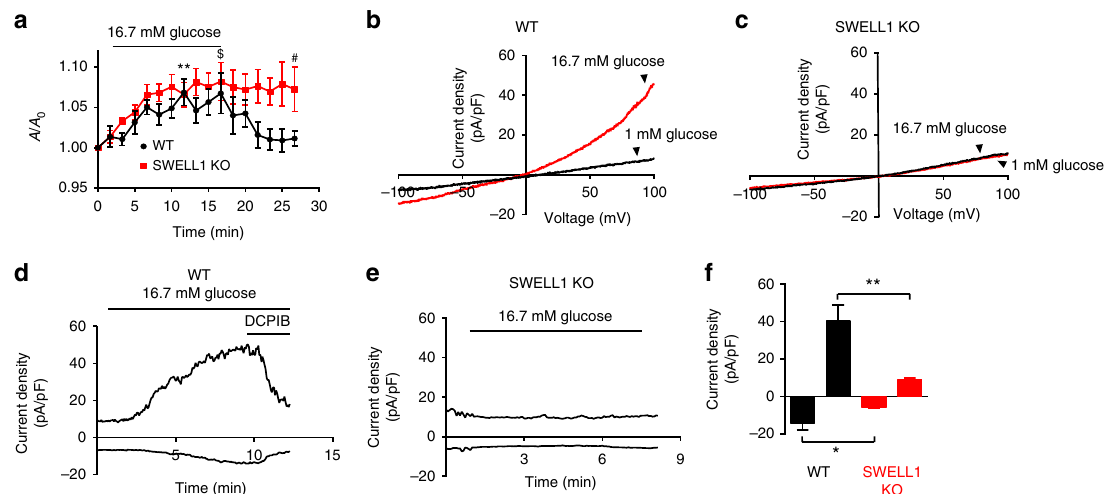
Fig. 2 β -cell I Cl,SWELL is activated by physiological swelling in response to glucose stimulation. a Cross-sectional area of primary WT ( n = 12 cells) and Swell1 KO ( n = 7 cells) murine β -cells in response to glucose stimulation (16.7 mM glucose). b , c Representative current – voltage relationship of I Cl,SWELL in b WT and c Swell1 KO murine primary β -cell in response to 1 mM glucose (black trace) and 16.7 mM glucose (red trace). d , e Representative current – time relationship of I Cl,SWELL from d WT and e Swell1 KO murine primary β -cell upon application of 16.7 mM glucose+DCPIB (10 µ M, in WT only). f Mean current inward and outward densities at +100 and − 100 mV (WT = 4 cells; Swell1 KO = 5 cells). Recordings in b – e were all performed at 35 – 37 °C in perforated patch con fi guration. Ramp protocol is from +100 mV to − 100 mV (ramp duration: 500 ms, holding potential: 0 mV). Data are shown as mean ± s.e.m. In a , ** p < 0.01 vs. 0 min in WT, paired t -test; $ p < 0.05 vs. 0 min in Swell1 KO, paired t -test; # p < 0.05 WT vs. Swell1 KO, unpaired t -test. In f , * p < 0.05; ** p < 0.01, unpaired t